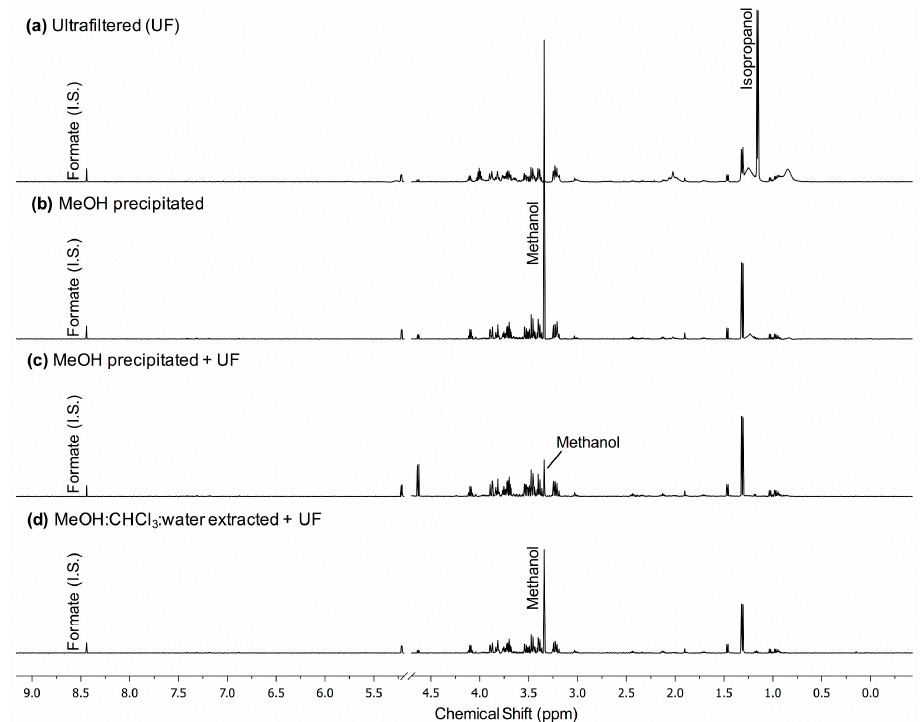
Figure 2. Representative 1 H-NMR spectra of pooled healthy human serum subjected to a variety of macromolecule removal strategies. Spectra were acquired on a Varian (500 mHz) NMR spectrometer with 32 transients (for pulse sequence, see text). ( a ) Ultrafiltration (UF) alone, ( b ) MeOH ppt alone,